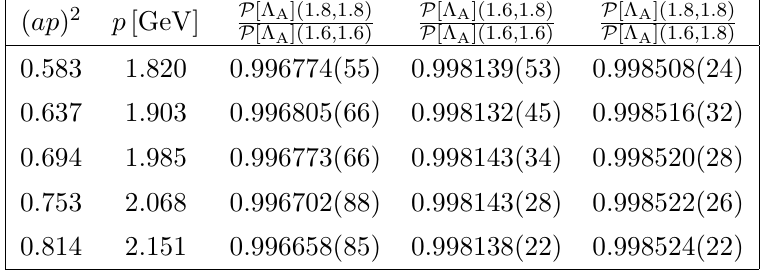
Table 6 . The ratios of projected amputated vertex function for the axial currents with di(cid:11)erent actions on the M1 ensemble. The quark mass for both (cid:12)elds is taken to be am l = 0 : 004.